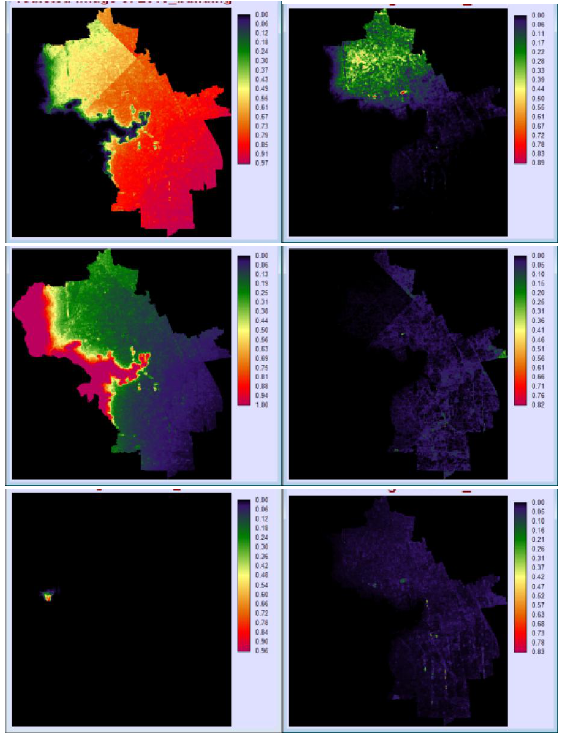
Fig. 10 land cover suitability atlas, Haidian District